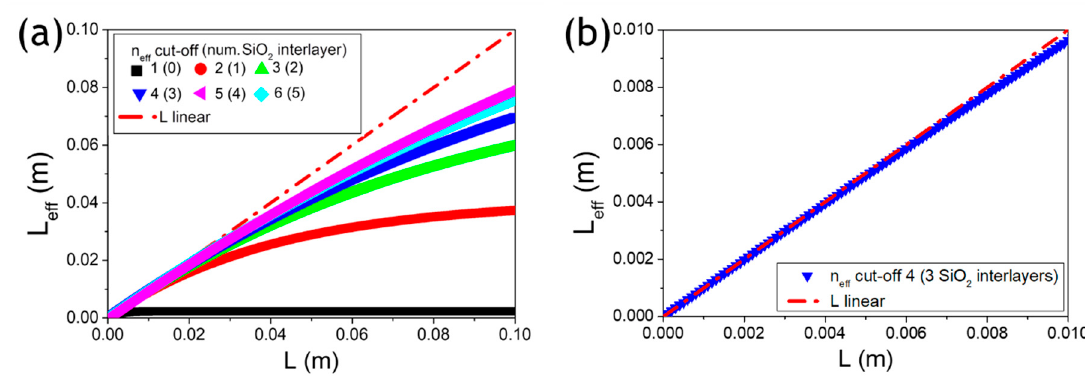
Figure 7. ( a ) Free-carrier absorption (FCA) effective length ( L FCA,eff ) vs. WG length (L) for different numbers of SiO 2 interlayers. The linear behavior is also plotted in the graph (red dot) and ( b ) shows L FCA,eff for 3 SiO 2 interlayers below 10 mm.